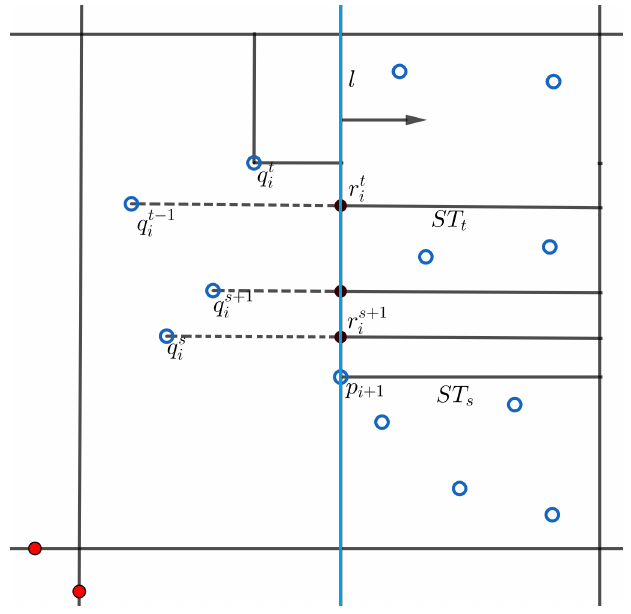
Figure 2. While sweeping vertical line l over point p i + 1 , the staircase ST t is